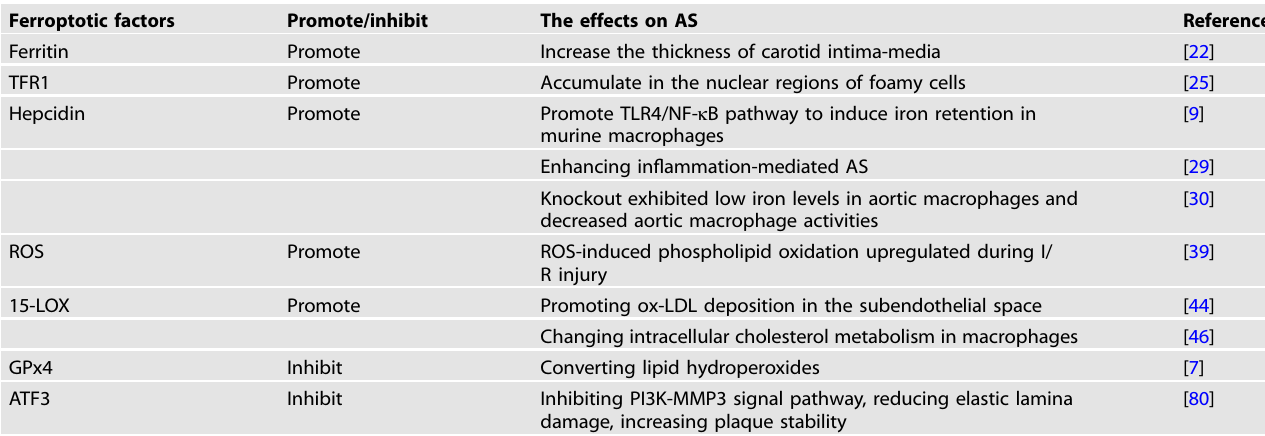
Table 1. The effects of ferroptotic factors on AS. Ferroptotic